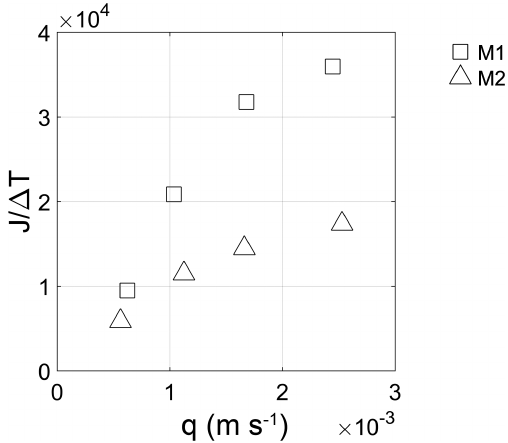
Figure 7. Relationship between Pe and Nu v .